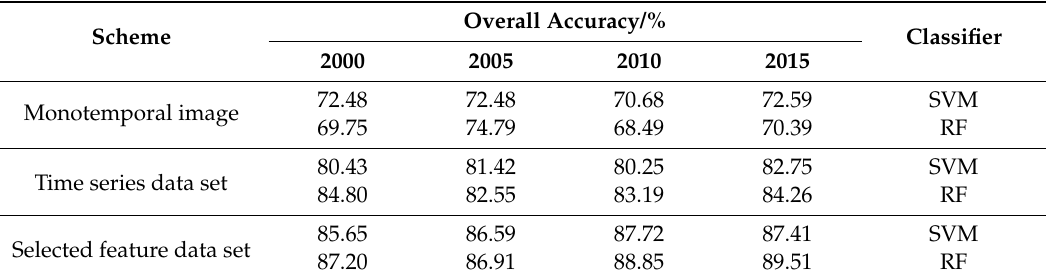
Table 10. Classification accuracies comparison of different classification schemes.